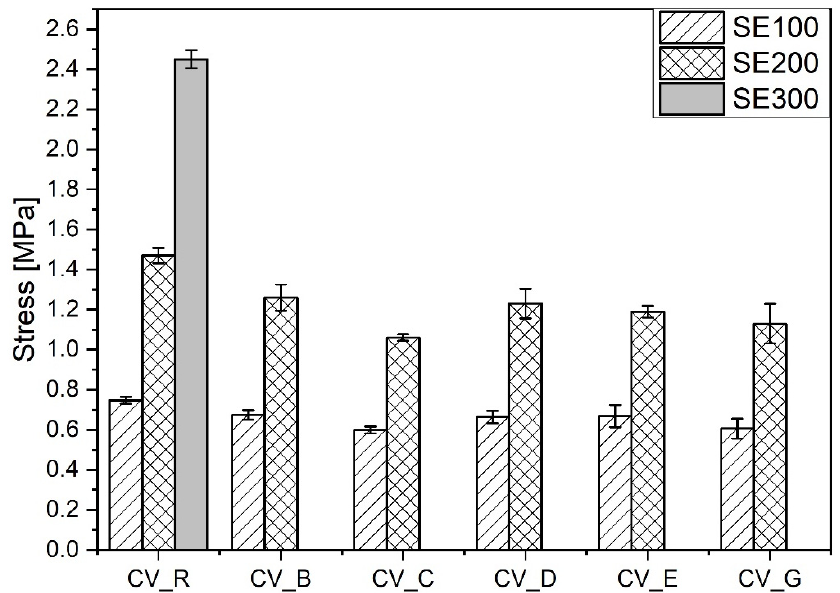
Figure 8. Mechanical properties in the extension of rubber compounds cured in the CV system.